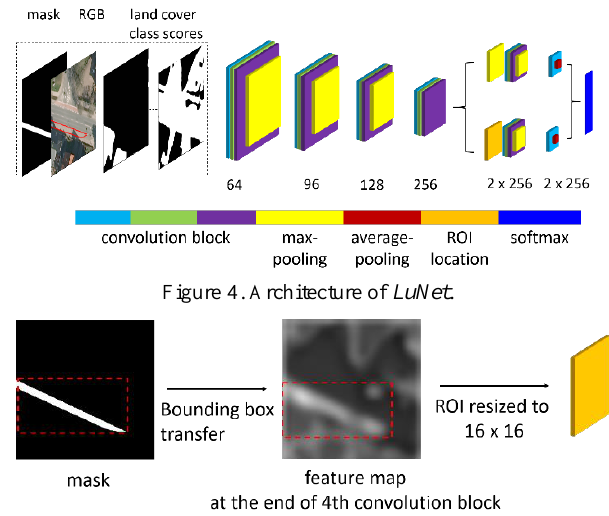
Figure 5. ROI location (red rectangle) and feature